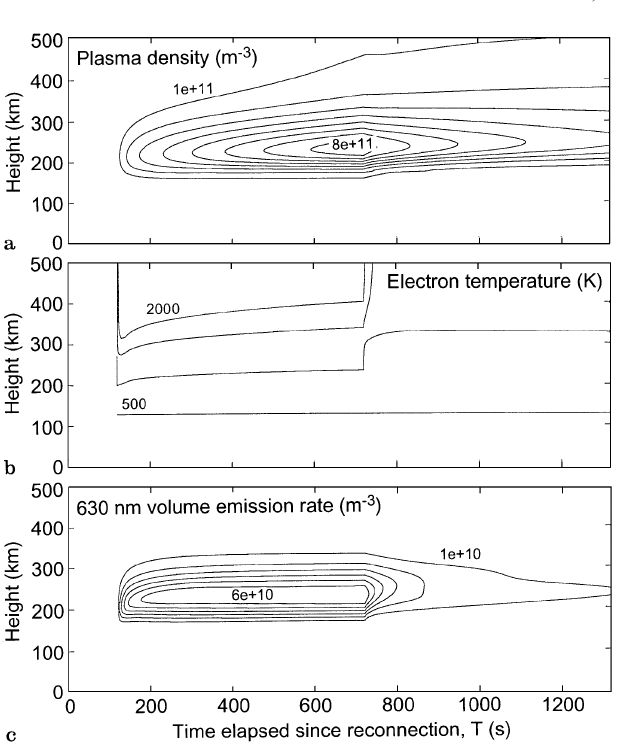
Fig. 2a (cid:177) c. Variations of parameters predicted by the auroral model as a function of „ and h , for a square wave variation of electron precipitation flux between „" 120 s and „" 720 s. a N (cid:101) , from 1 (cid:93) e (cid:49)(cid:49) to 8 (cid:93) e (cid:49)(cid:49) m (cid:126)(cid:51) ; b „ (cid:101) from 500 to 2000 K and c the volume emission rate at 630 nm from 1 (cid:93) e (cid:49)(cid:48) to 6 (cid:93) e (cid:49)(cid:48) m (cid:126)(cid:51)